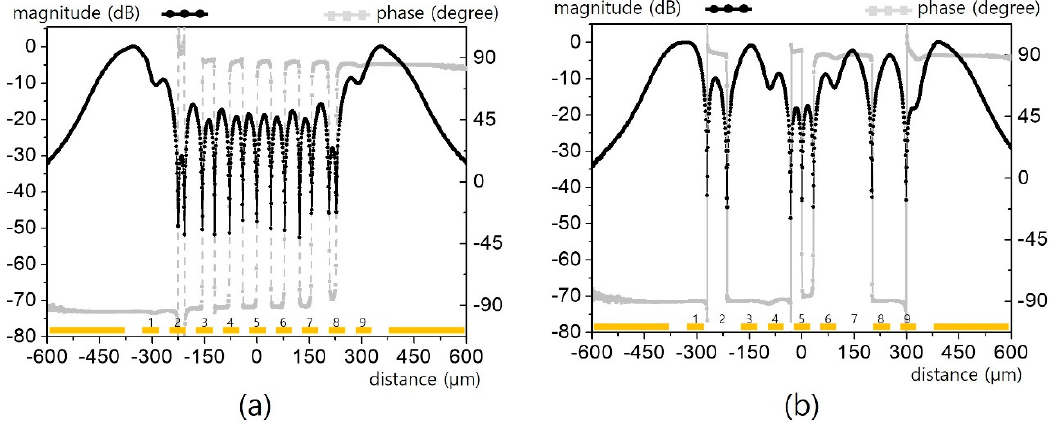
Figure 8. Horizontal electric field distribution over nine ( n = 9, L/g/G = 50/30/52 μ m) CPW lines in Figure 6: ( a ) for lines without defects, and ( b ) for lines with defects.